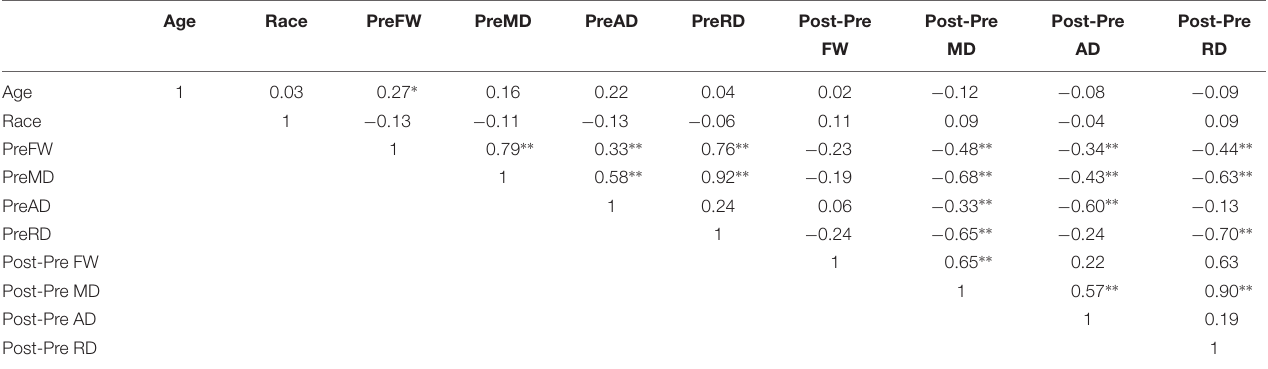
TABLE 2 | Correlations among and descriptive statistics for demographic and dependent variables. Age Race PreFW PreMD PreAD PreRD Post-Pre Post-Pre Post-Pre